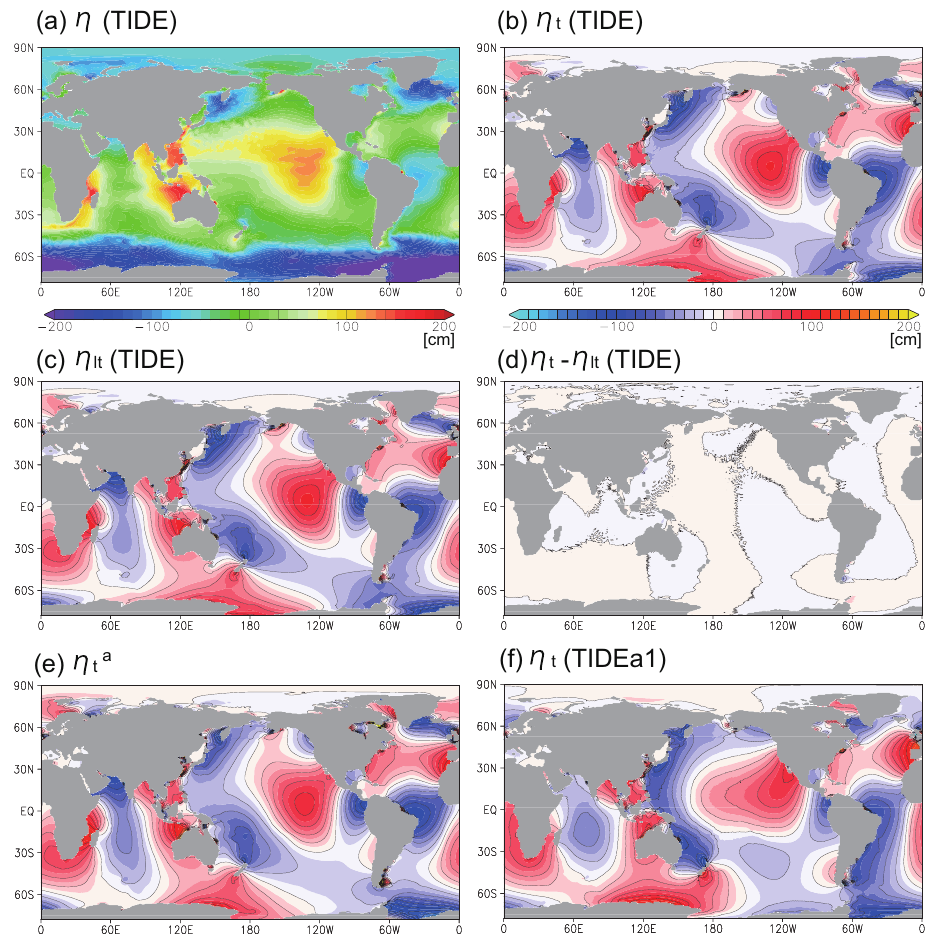
Fig. 2. (a) SSH η , (b) tidal height η t , (c) height of the linear tidal component η lt , (d) the difference η t − η lt in case TIDE, (e) data assimilation analysis η a t (Matsumoto et al., 2000) and (f) η t in TIDEa1 at the end of the 40-day experiments (20 June 2001 00:00UTC). The same colors Fig. 2. (a) SSH (cid:17) , (b) tidal height (cid:17) , (c) height of the linear tidal component (cid:17) , (d) the difference t lt are used in (b–f) ; red indicates ascend (positive), whereas blue indicates descend (negative). The contour interval is 20cm. − (cid:17) (cid:17) in case TIDE, (e) data assimilation analysis (cid:17) a (Matsumoto et al., 2000) and (f) (cid:17) in TIDEa1 at t lt t t the end of the 40-day experiments (20 Jun 2001 0:00 UTC). The same color shades are used in (b)-(f), and red indicates ascend (positive) while blue descend (negative). The contour interval is 20 cm. who proposed an interpretation of horizontal viscosity as a way to parameterize the interaction between mesoscale ed- 37 dies and internal waves. That is, the usage of different values means that mesoscale eddies interact differently with inter- nal waves that result from geostrophic adjustment than with internal tides. The experimental period was 10 days in M2, K1, M2v2 and